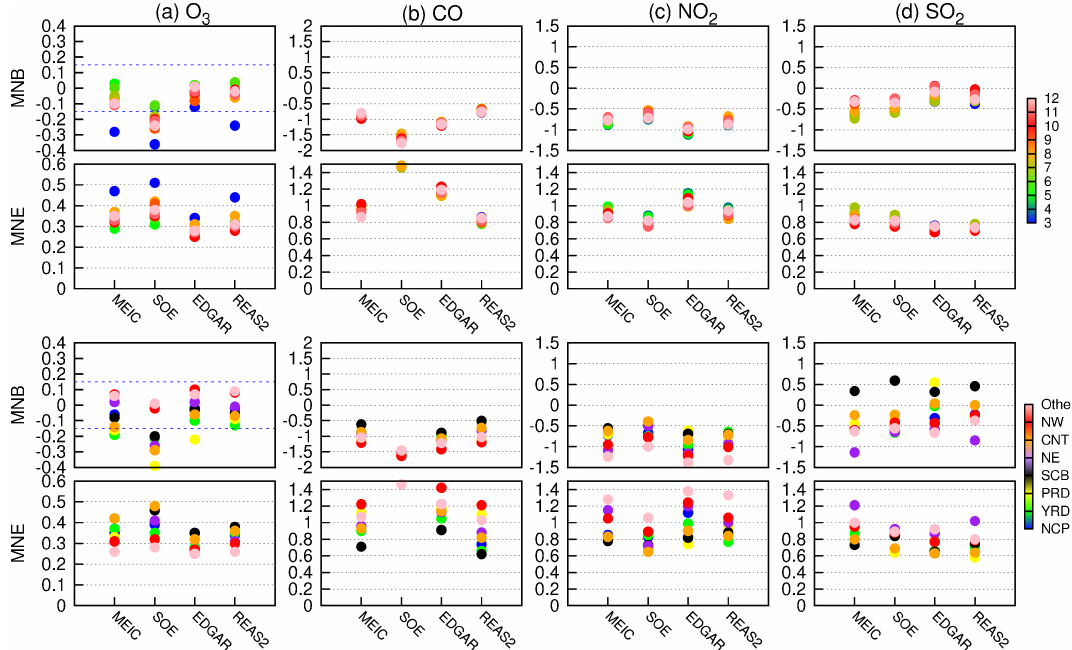
Figure 2. Performance of predicted O 3 , CO, NO 2 , and SO 2 for different months (top two rows) and regions based on simulations with individual inventories. The blue dashed lines on the O 3 plots are ± 0.15 for MNB and 0.3 for MNE as suggested by the U.S. EPA (2001). Changes of colors show the months from March to December in top two rows (3 refers to March, 12 to December, etc.), while showing regions from NCP to Other in the bottom two